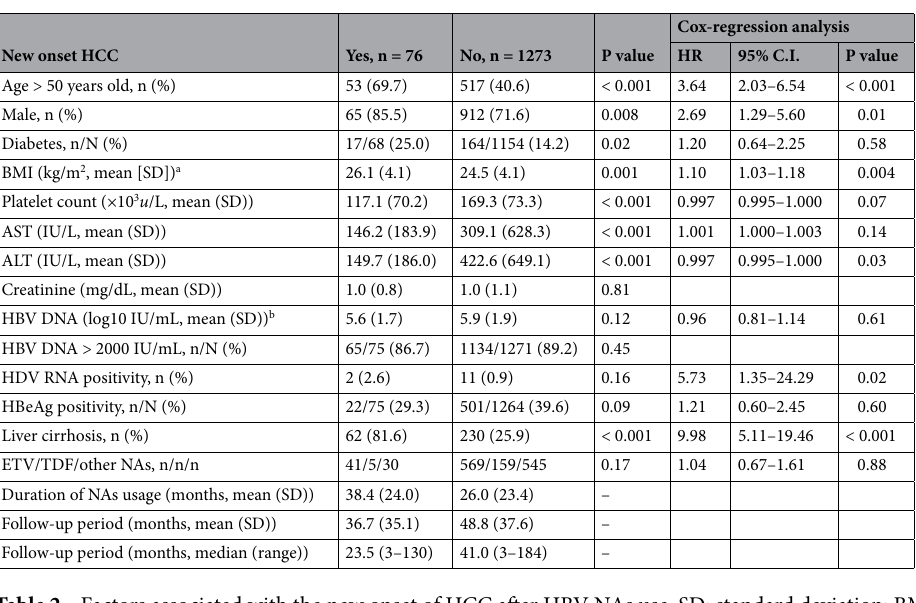
Table 2. Factors associated with the new onset of HCC after HBV NAs use. SD: standard deviation; BMI: body mass index; AST: aspartate aminotransferase; ALT: alanine aminotransferase; HBsAg: hepatitis B surface antigen; HBV: hepatitis B virus; HDV: hepatitis D virus; HBeAg: hepatitis B e-antigen; FIB-4: fibrosis-4 index; HCC: hepatocellular carcinoma; NAs: nucleotide analogues; ETV: entecavir; TDF: tenofovir disoproxil fumarate; HR: hazard ratio; CI: confidence interval. a n = 1309. b n = 1346.